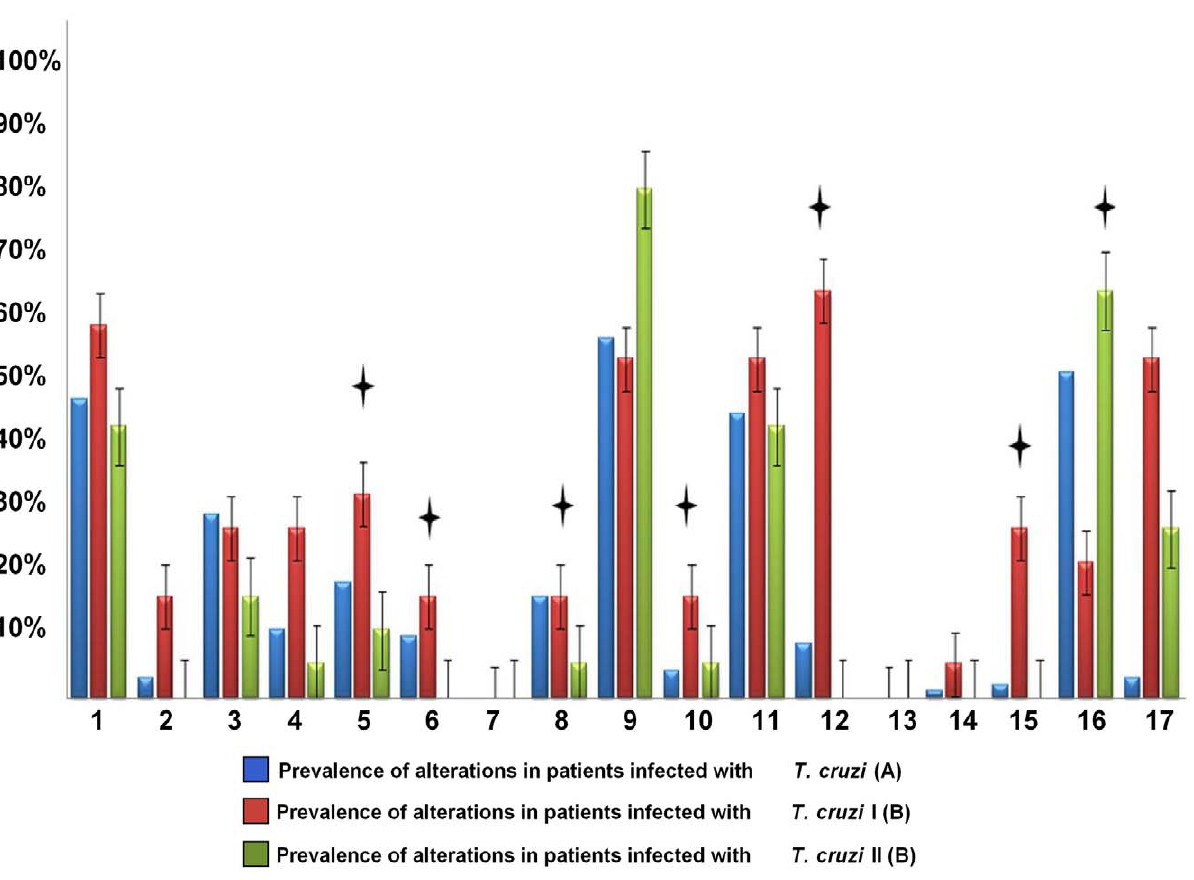
Figure 4. Prevalence of electrocardiographic, radiologic and echocardiogram alterations in chronic Chagasic patients from Colombia. (A) Prevalence of alterations based on 240 chronic Chagasic patients, (B) Prevalence of alterations based on 20 selected chronic Chagasic patients. Right bundle-branch block (1), left bundle-branch block (2), left anterior fascicular block (3), left posterior fascicular block (4), ventricular premature beats (5), first degree atrioventricular block (6), Mobitz type I atrioventricular block (7), sinus bradycardia (8), primary ST-T changes (9), abnormal Q-waves (10), low voltage QRS (11), atrial fibrillation (12), Mobitz type II atrioventricular block (13), complete atrioventricular block (14), complex ventricular arrhythmias (15), evidence of regional wall motion abnormality (16), reduced global left ventricular function and increased cardiothoracic ratio (17). (*) Statistically significant comparisons of TcI vs. TcII cardiac alteration using Tukey test.